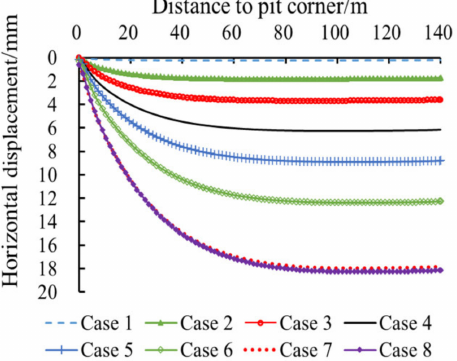
Figure 18. Horizontal displacement of piles top along long side.